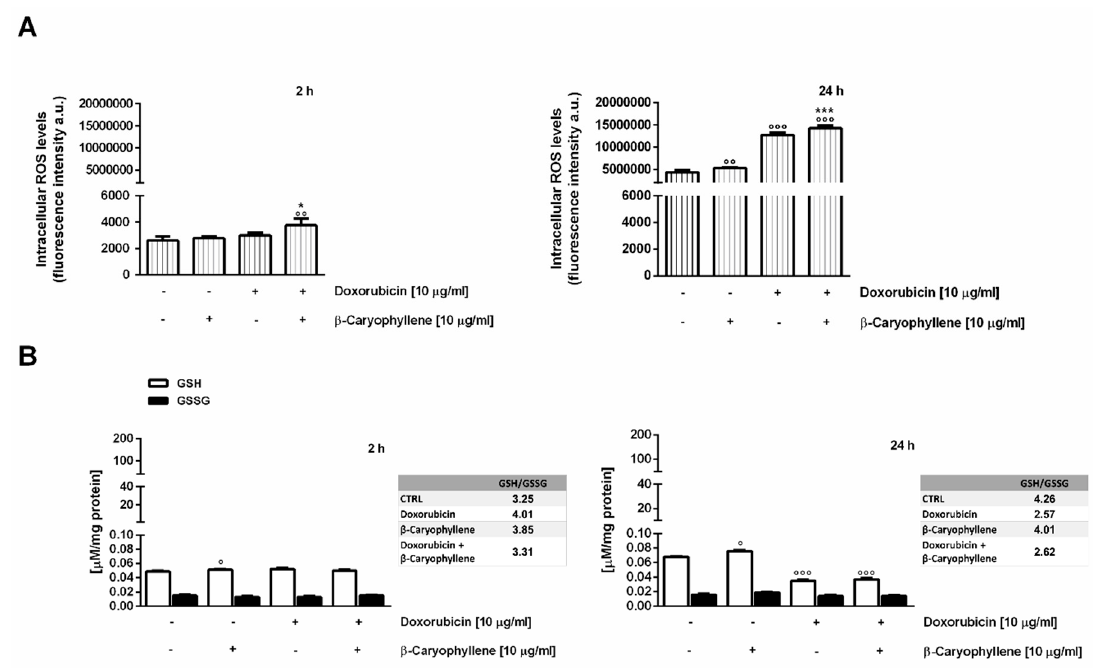
Figure 9. Effect of the natural sesquiterpene β -caryophyllene (50 µM), doxorubicin (20 µM) and their combination compared the control on the intracellular oxidative stress in H69 noncancerous cholangiocytes. The cells were treated for 2 h and 24 h, then the pellets were harvested for the subsequent analysis. ( A ) Bar graphs representing the levels of reactive oxygen species (ROS) as detected by the 2,7-dichlorofluorescein diacetate (DCFH-DA) assay. Data are expressed as mean ± standard error of at least two independent replicates. ( B ) Bar graphs representing the levels of GSH (reduced glutathione) and GSSG (oxidized glutathione) as revealed by HPLC analysis. Data are expressed as mean ± standard error of at least two independent replicates. ° p < 0.05, °° p < 0.01 and °°° p < 0.001 (one-way ANOVA followed by Dunnett’s multiple comparison post-test) denote a significant difference of the treatments compared the control. * p < 0.05 and *** p < 0.001 (t-Student test) denote a significant difference with respect to doxorubicin.